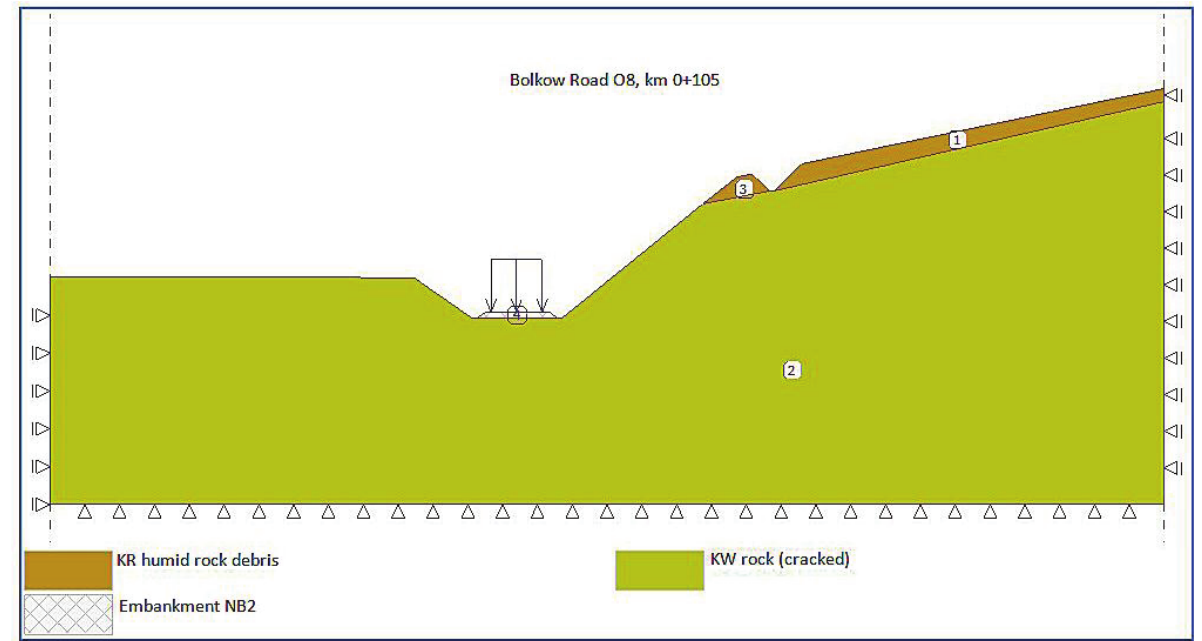
Figure 13. Designed slope profile of the road O8 excavation in the cross section of km 0 + 105.00